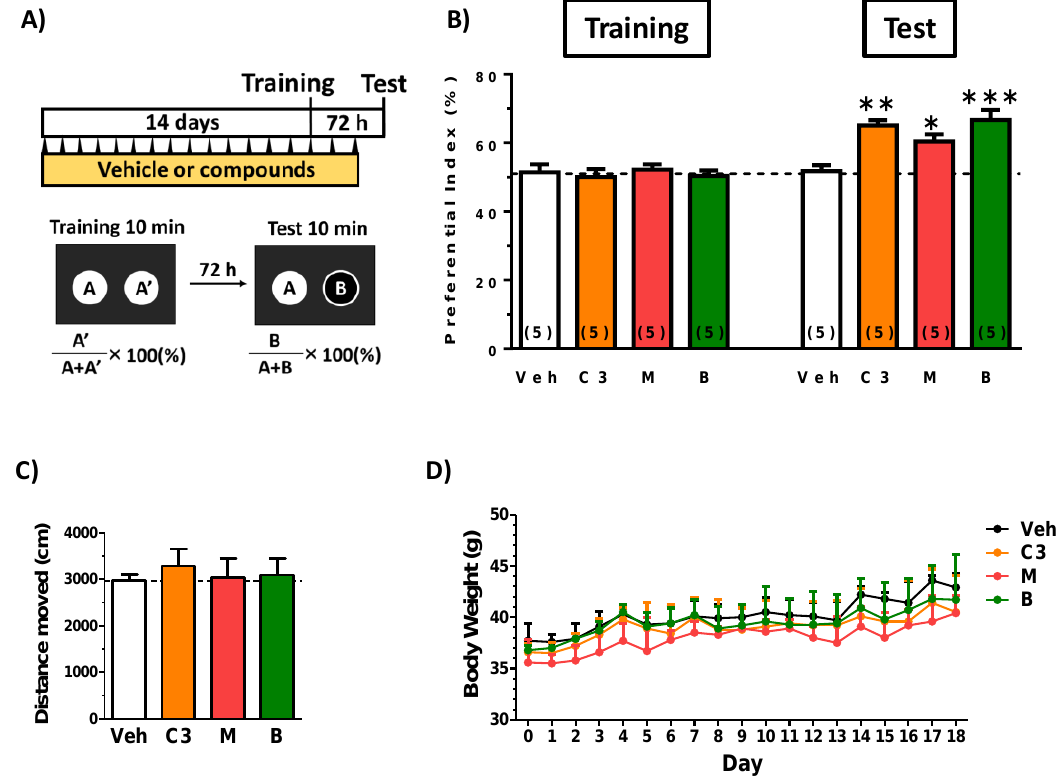
Figure 6. Effects of ciwujianoside C3, eleutheroside M and ciwujianoside B on object recognition memory in mice. ( A ) Ciwujianoside C3 (C3), eleutheroside M (M), ciwujianoside B (B) (each 0.5 mg /